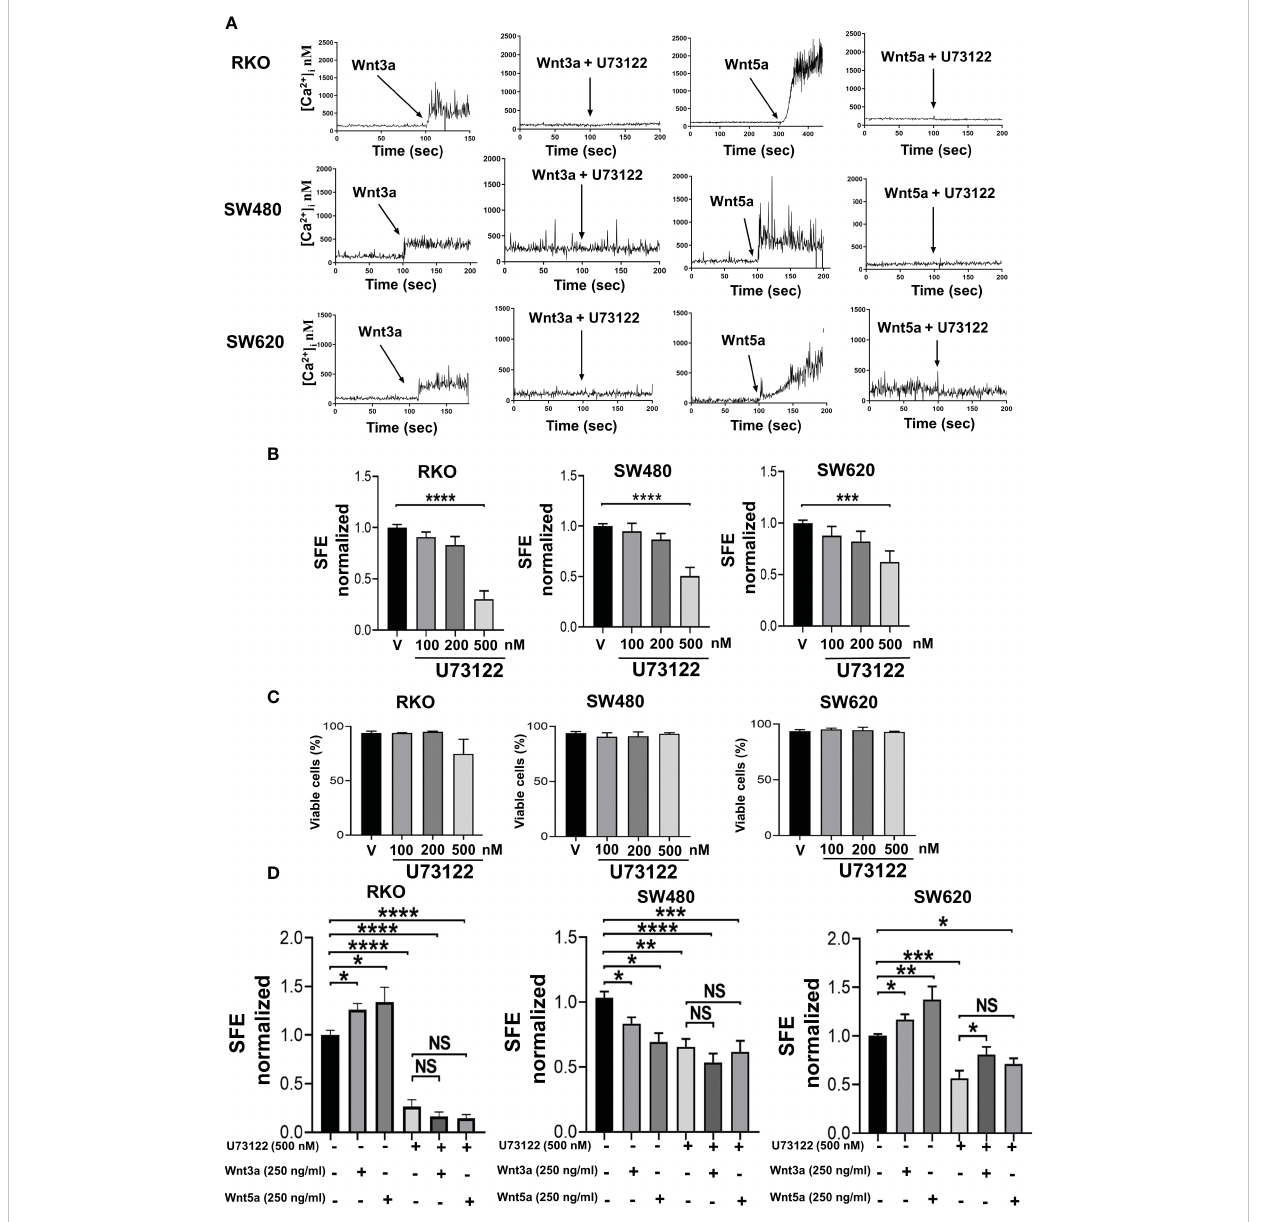
FIGURE 5 Inhibition of PLC impairs sphere formation. (A) Both Wnt5a or Wnt3a increase cytosol calcium concentration in RKO, SW480 or SW620 spheres that was blocked by pretreatment of sphere cells with PLC-speci fi c inhibitor U-73122. Cells were serum-starved overnight and then loaded with 2.5 m M of Fura-2/AM in Krebs-Ringer-HEPES containing 0.05% BSA, pH 7.4, for 1 h at 37 a C. Cells were washed and sphere cells stimulated with the conditioned medium containing Wnt3a or Wnt5a. Additionally, the spheres were pre-treated in the absence or presence of 4 µM PLC inhibitor U73122 before stimulation, as indicated. Traces are representative of three experiments using different cell preparations. (B) Quantifying SFE in spheres of RKO, SW480, and SW620 cells treated with the PLC inhibitor U73122 at the indicated concentrations each third day. (C) Quanti fi cation of viable cells of spheres of RKO, SW480, and SW620 under the same conditions as described in panel (B) Evaluation was performed by IP staining and detected by fl ow cytometry on the 11 th day of culture. (D) Quantifying SFE in spheres of RKO, SW480, and SW620 cells treated with U73122, Wnt3a, Wnt5a, or a combination of them. The concentration of each stimulus is indicated in the fi gure. Data are represented as the mean values ± SEM of at least three independent experiments. Statistical analysis was performed using one-way ANOVA followed by Bonferroni´s multiple comparisons. *p<0.05; **p<0.01; ***p<0.001; ****p<0.0001; NS, not signi fi